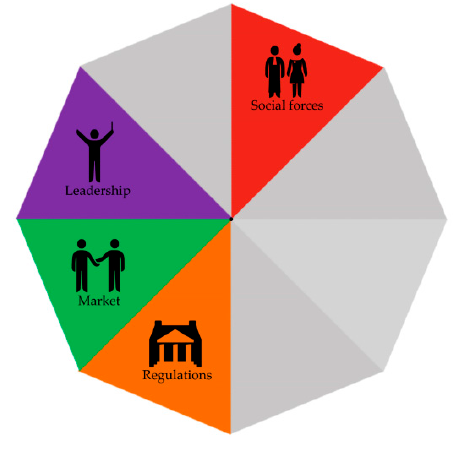
Figure 4. Bridging perspectives .